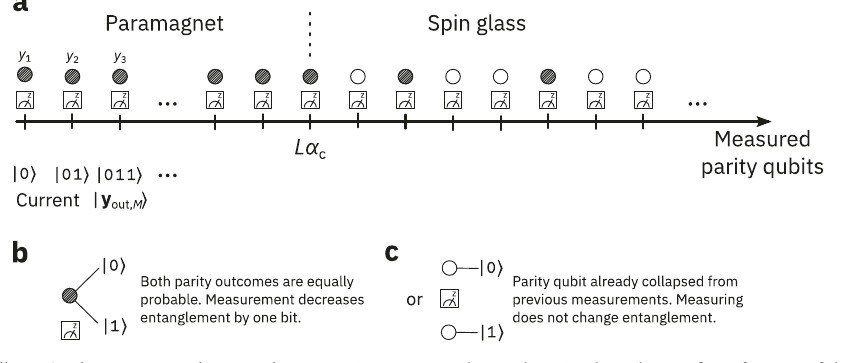
Fig. 2 | Measurement and collapse in the two entanglement phases. a Prior to measurement, each parity qubit is either in a superposition as in ( b ), or already collapsed from previous measurements as in ( c ). In the paramagnetic phase, measurement collapses the parity qubit, decreasing the entanglement entropy by